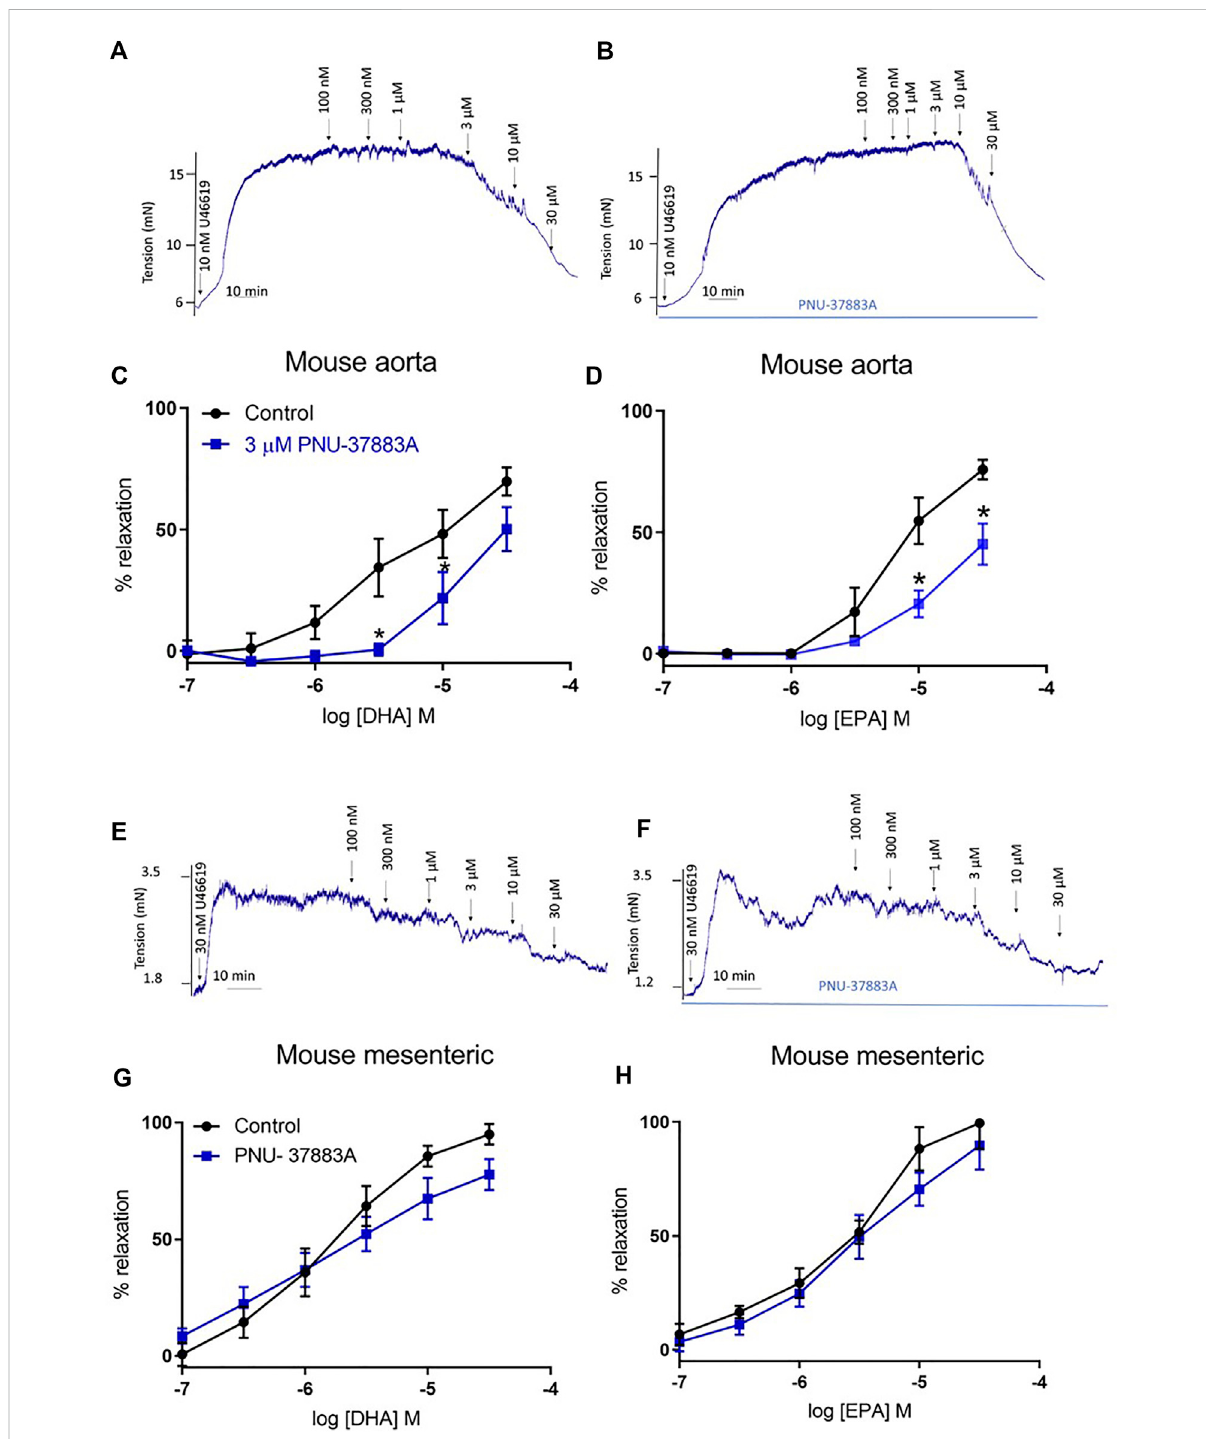
FIGURE 1 Concentration response curves showing the effects of inhibition of K ATP channels on n-3 PUFA-induced relaxation in mouse aorta and mesentericpreconstrictedwithU46619. (A) RepresentativeorganbathtracesshowingtheeffectofDHA(100 nm – 30 μ m)onmouseaortictone. (B) Representative organ bath traces showing the effect of PNU-37883A treatment on DHA (100 nm – 30 μ m)-induced changes in mouse aortic tone. (C) DHA- and (D) EPA-induced relaxation in mouse aorta following treatment with the K ATP inhibitor PNU-37883A (3 µm). (E) Representative organbathtracesshowingtheeffectofDHA(100 nm – 30 μ m)onmousemesenterictone. (F) Representativeorganbathtracesshowingtheeffectof PNU-37883A treatment on DHA (100 nm – 30 μ m)-induced changes in mousemesenteric tone. (G) DHA- and (H) EPA-induced relaxation in mouse mesenteric following treatmentwith the K ATP inhibitor PNU-37883A (3 µm). n = 5, data represented as mean ± SEM. * p < 0.05, signi fi cant difference from control curve assessed by 2-way ANOVA followed by Bonferroni multiple comparison